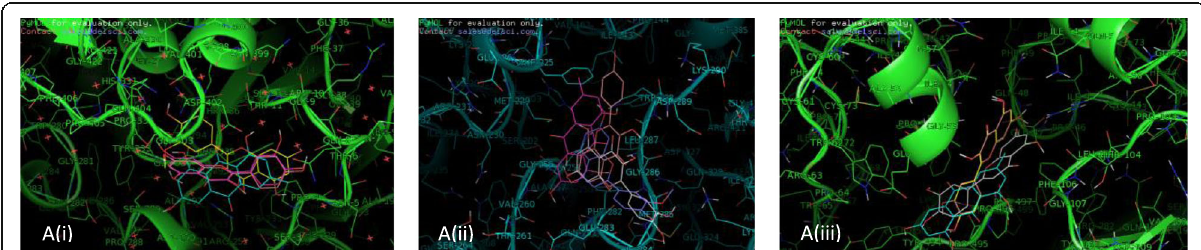
Fig. 2 Superimposition of 3D structures of emodin, quercetin, chrysoeriol, and kaempferol inside the binding site of A(i) α -amylase (1HNY), A(ii) α -glucosidase (5ZCB), and A(iii) sucrase-isomaltase (3LPO)